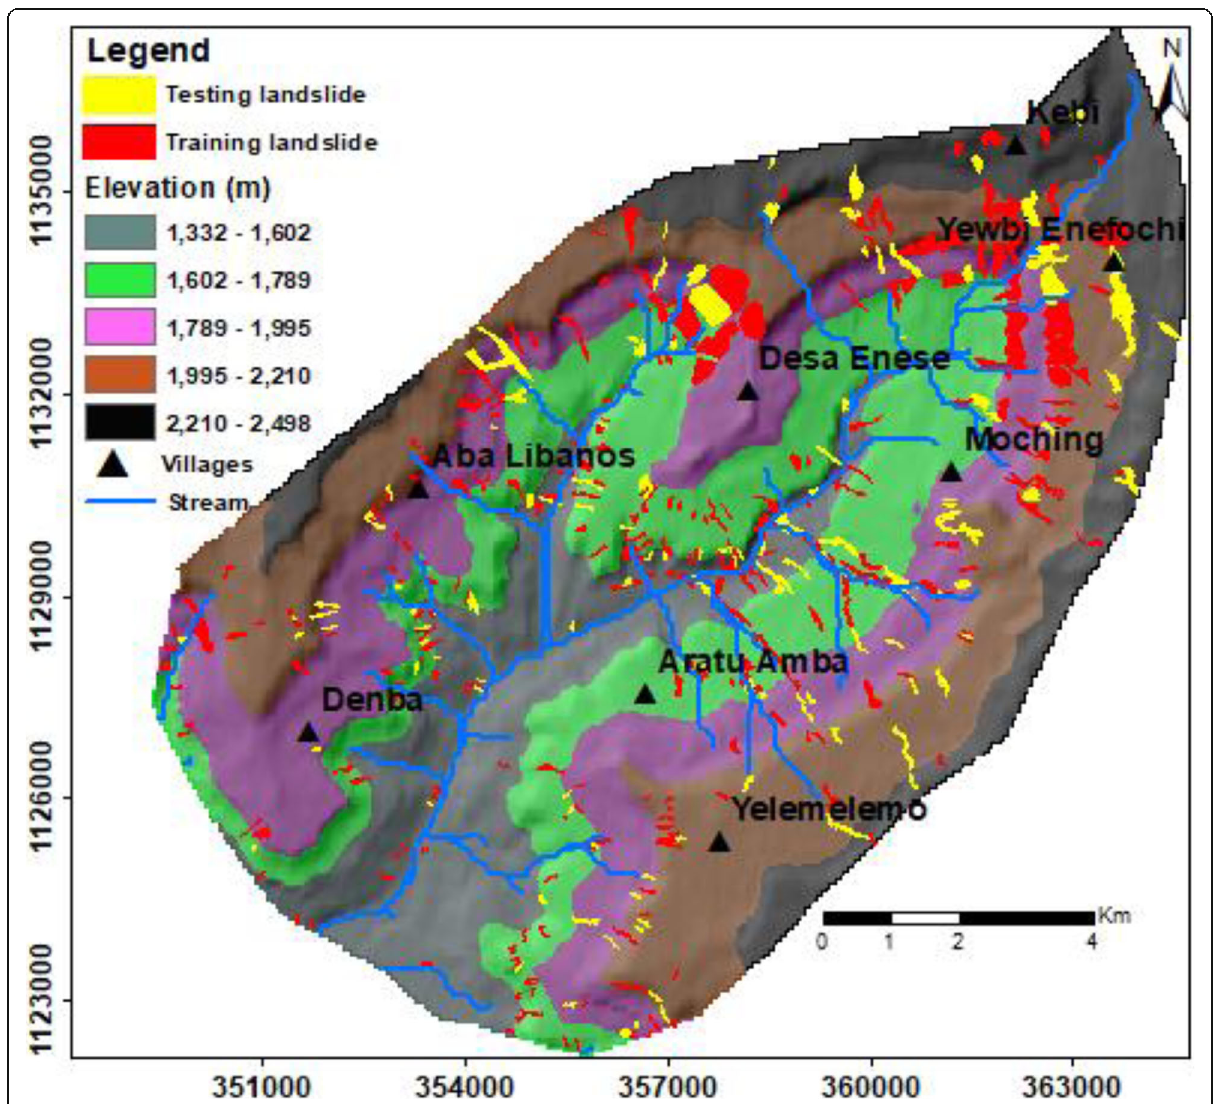
Fig. 5 Landslide Inventory Map of the Study